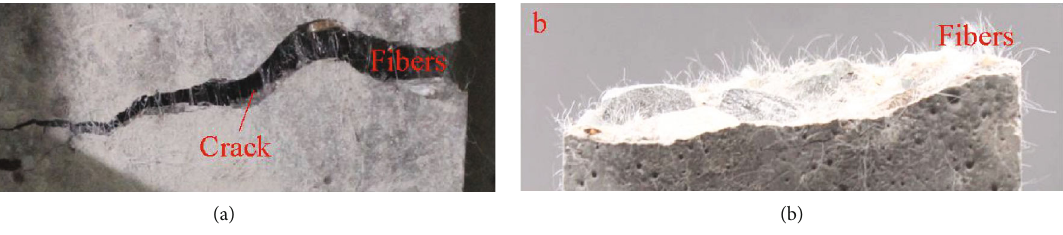
Figure 24: Fibers bridging at the crack section.